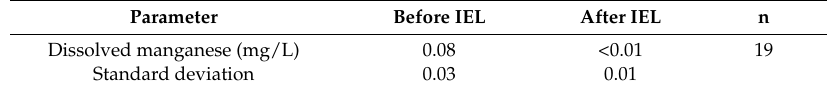
The removal performance of the inline electrolysis (IEL) for manganese with standard deviation.